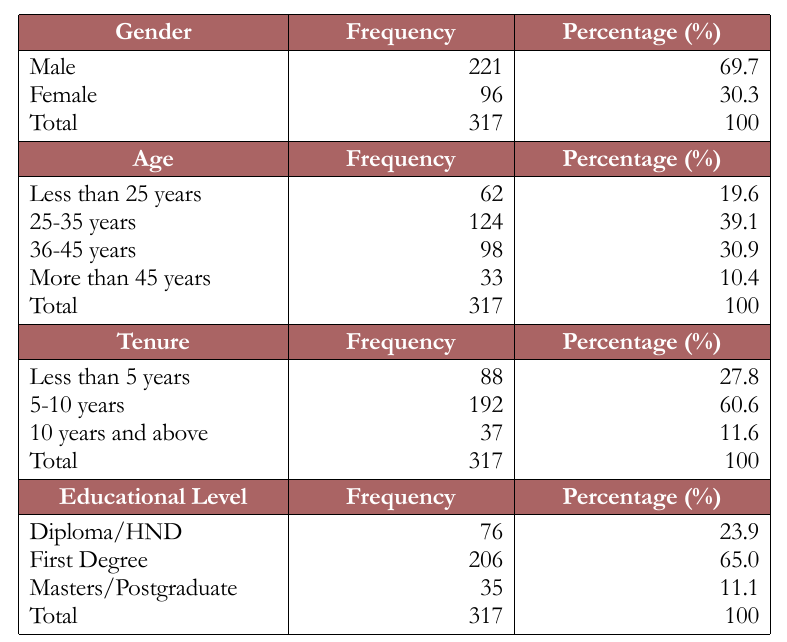
Table 1. Demographic data of